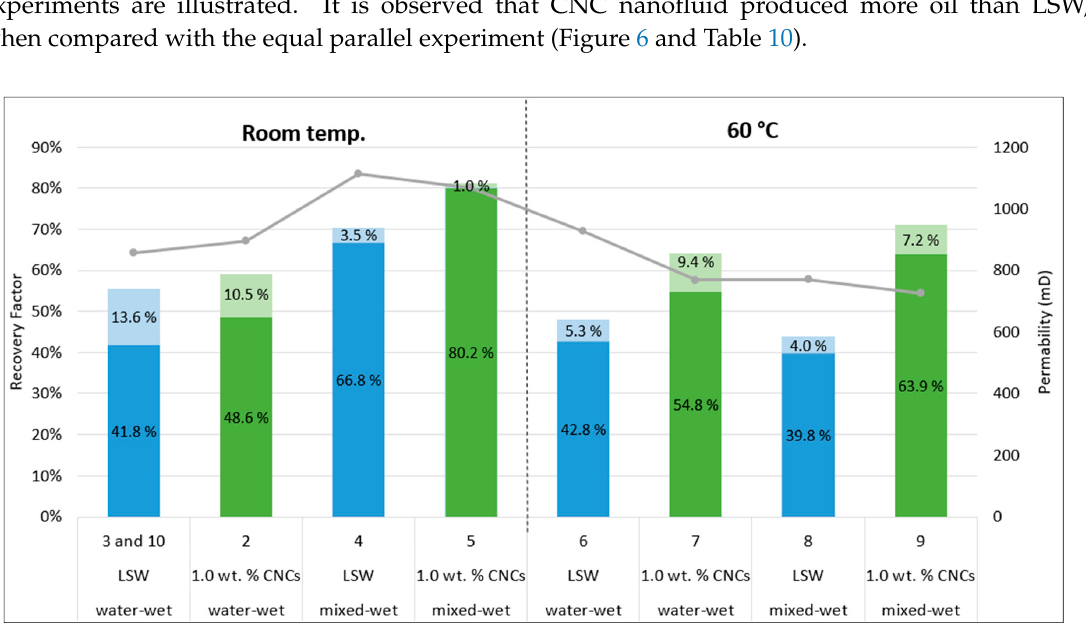
Figure 6. Recovery factors (% of original oil in place (OOIP)) and permeability of secondary recovery experiments. The vertical black dotted line acts as a marker between the experiments conducted at room temperature and 60 °C. Dark blue or dark green colors represent the recovery factor achieved from the low rate flooding (0.3 mL / min), while the lighter colors denote the recovery from the high rate flooding (3.0 mL / min). The numbers on the x -axis corresponds to the test number.